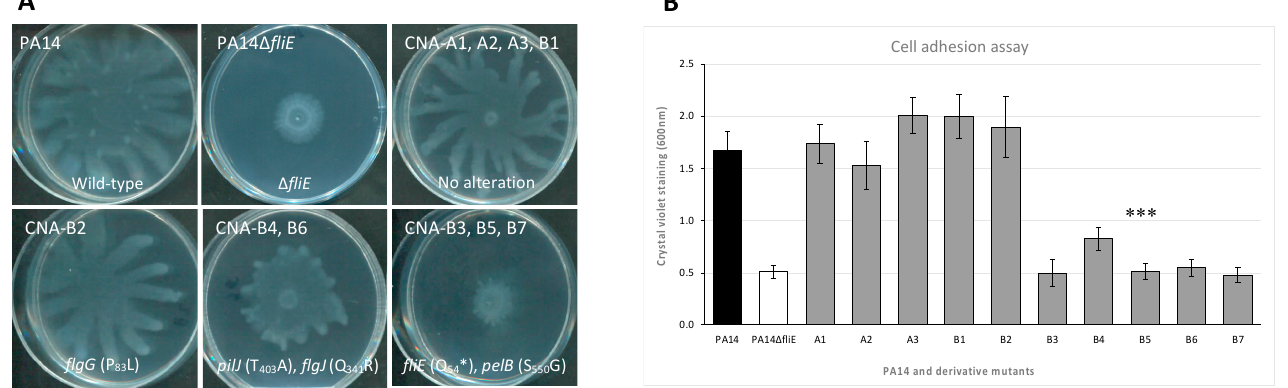
Figure 2. Motility and initial surface attachment of CNA-resistant mutants . ( A ) Swarming motility: 236 the mutations found in genes responsible for flagellar structure/assembly, pili formation, and bio- 237 synthesis of biofilm matrix are indicated. ( B ) Absorbance at 600 nm is representative of sessile bac- 238 teria stained by crystal-violet in microplates (mean values resulting from 10 replicates; Student’s t- 239 test, ***p-value < 0.001).